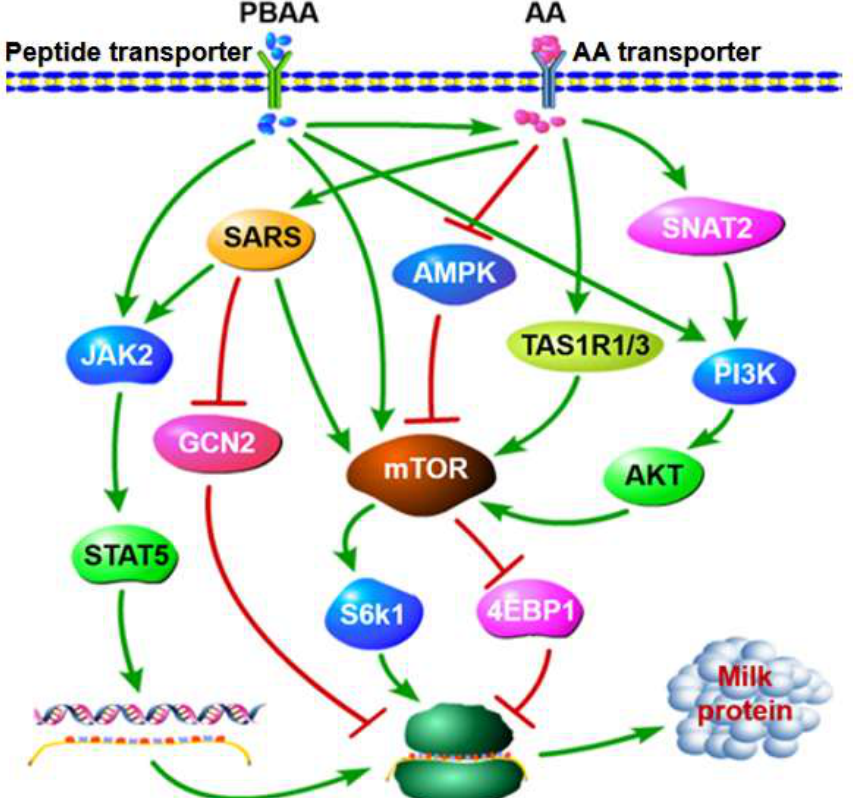
Figure 1. Signaling pathways of regulation of milk protein synthesis by free amino acids (FAAs) and peptide-bound amino acids (PBAA) in mammary epithelial cells (MECs). Free AAs are taken up by MECs via AA transporters. PBAAs are transported into MECs by peptide transporters and hydrolysed to free AAs after entering the cells. In the cells, these AAs up-regulate the mammalian target of rapamycin (mTOR) signaling pathway by activation of seryl-tRNA synthetase (SARS), AA taste 1 receptor member 1/3 (TAS1R1/TAS1R3), phosphatidylinositol-3-kinase (PI3K-AKT) pathways and inhibition of adenosine 5′-monophosphate-activated protein kinase (AMPK). In addition, AA can activate Janus kinase 2-signal transducer and activator of transcription 5 (JAK2-STAT5) and inhibit general control nonderepressible 2 kinase (GCN2) pathway by activation of SARS; → activation; inhibition.